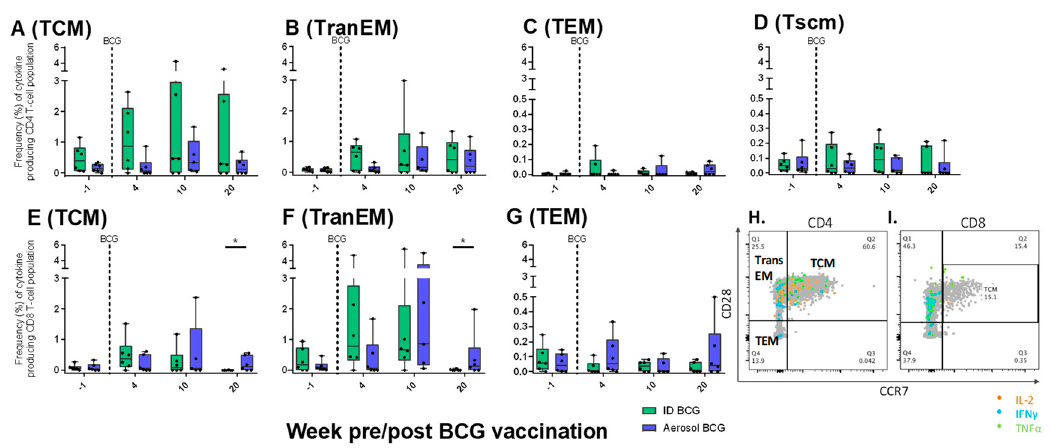
Figure 12. Antigen-specific CD4 and CD8 memory T-cell profiles measured in PBMCs. Plots H and I show representative bivariate density plots of central to effector memory T-cell populations defined by the pattern of CD28 and CCR7 staining on CD95 expressing CD4 ( H ) and CD8 ( I ) T-cells, overlaid with cytokine-producing cells represented as coloured dots. Plots A – G show the frequency of memory CD4 (Plots A – D ) and CD8 (plots E – G ) T-cell populations producing IFN- γ , IL-2 or TNF- α , measured prior to (week -1) and following (weeks 4, 10 and 20) BCG vaccination. Box plots show the group median and interquartile range with minimum and maximum values shown by whiskers.